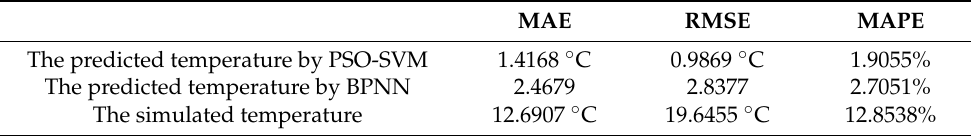
Table 3. Error analysis of the predicted and simulated temperature for solar cell module